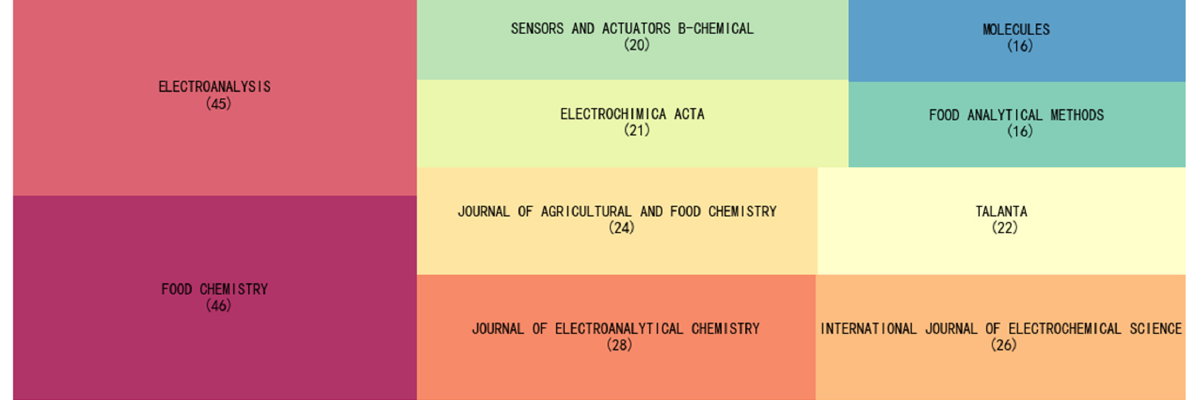
Figure 2. Top 10 journals that published articles on the evaluation of antioxidants using electrochemical sensors.